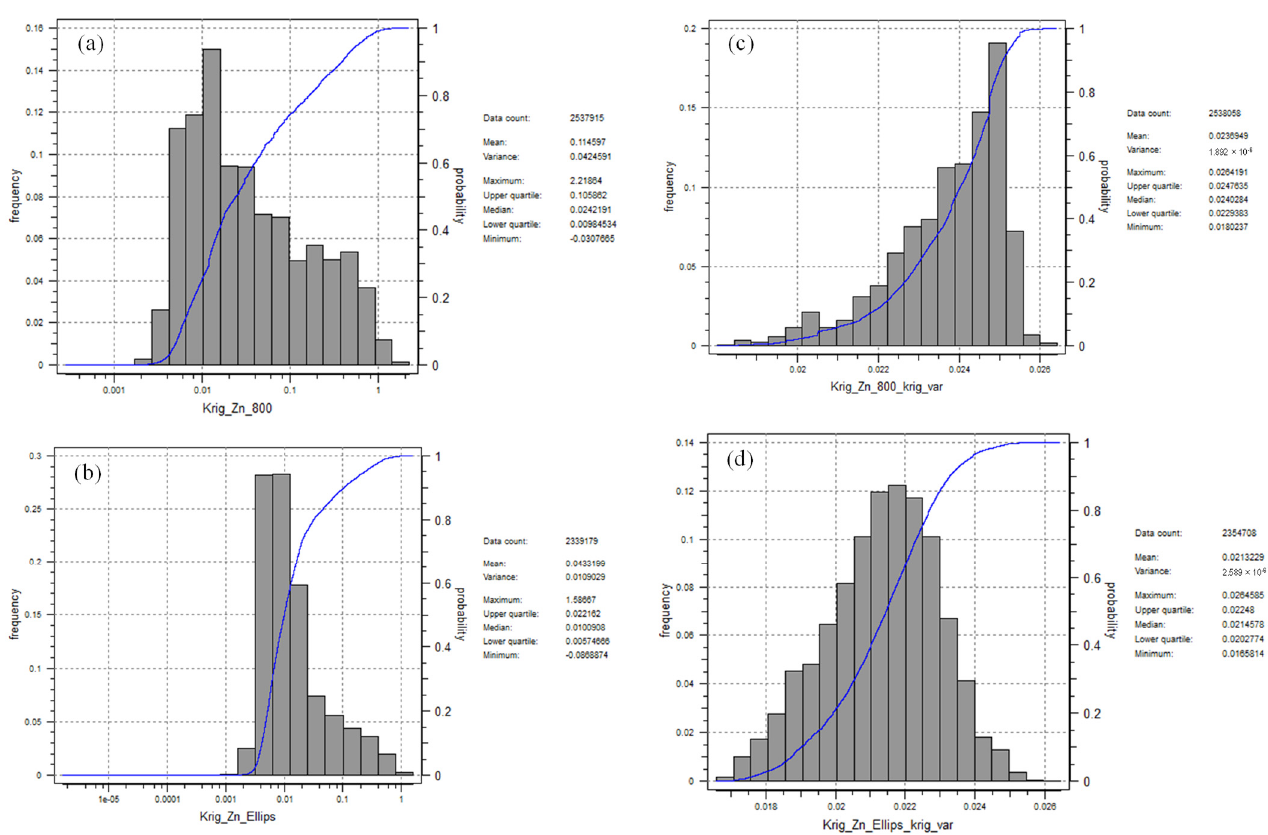
Figure 10. Histograms and cumulative distribution on Zn grade produced by kriging estimation using isotropy ( a ) and anisotropy ( b ) search radius as well as their kriging variances ( c , d ).